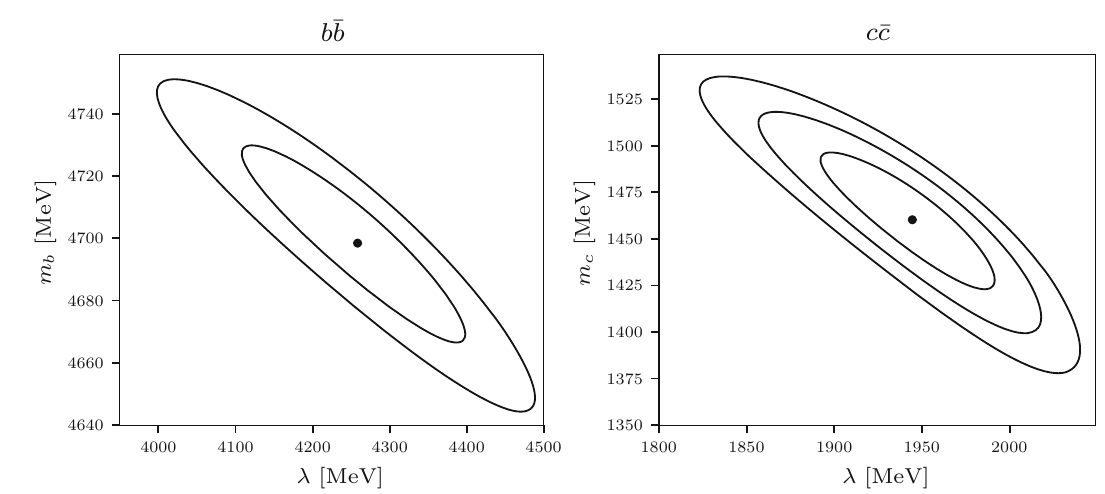
Fig. 6 Contour plots of the square root of mean squared deviation of the fit on λ – m plane for bottomonium and charmonium. The plotted contours correspond to 30 (for charmonium only), 40 and 50 MeV. Dots indicate best